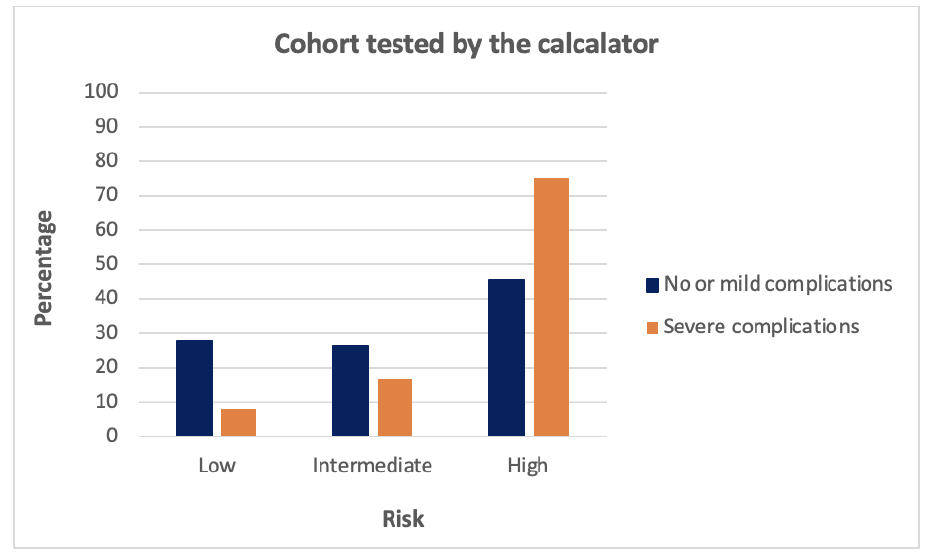
Figure 1. Results obtained from the online test of our cohort ( n = 308) with the calculator. It represents the percentage of patients within each category and whether the risk acquired by the calculator was low, intermediate, or high.